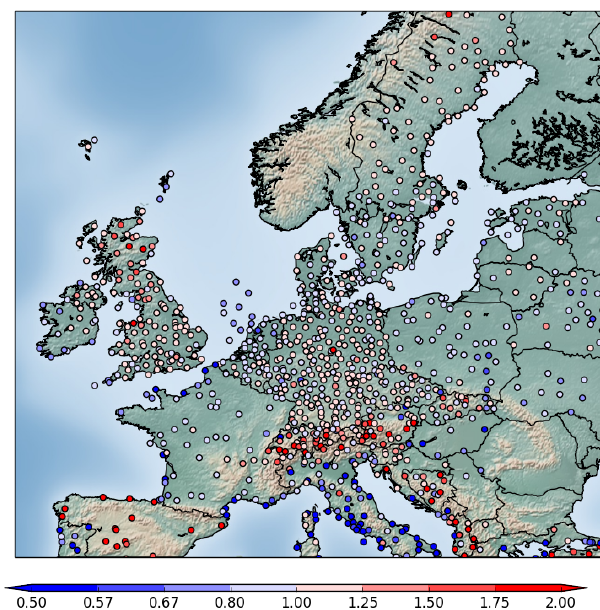
Figure 12. Frequency bias ((hits + false alarms) / (hits + misses)) of cloud-base height < 1km for cloud fraction ≥ 3 oktas in GA6 against surface station data. The mean bias of 6-hourly forecasts between 16 July 2014 and 15 July 2015 at a 24h forecast lead time are